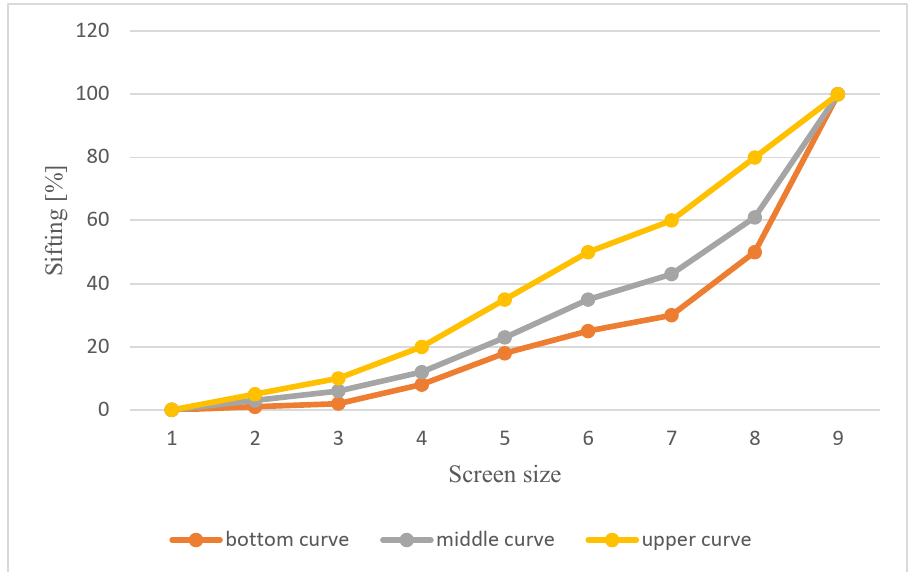
Figure 2. Concrete mixers: cement, settlement ash, leachate: ( A ) cement; ( B ) natural slag; ( C ) aggregate.